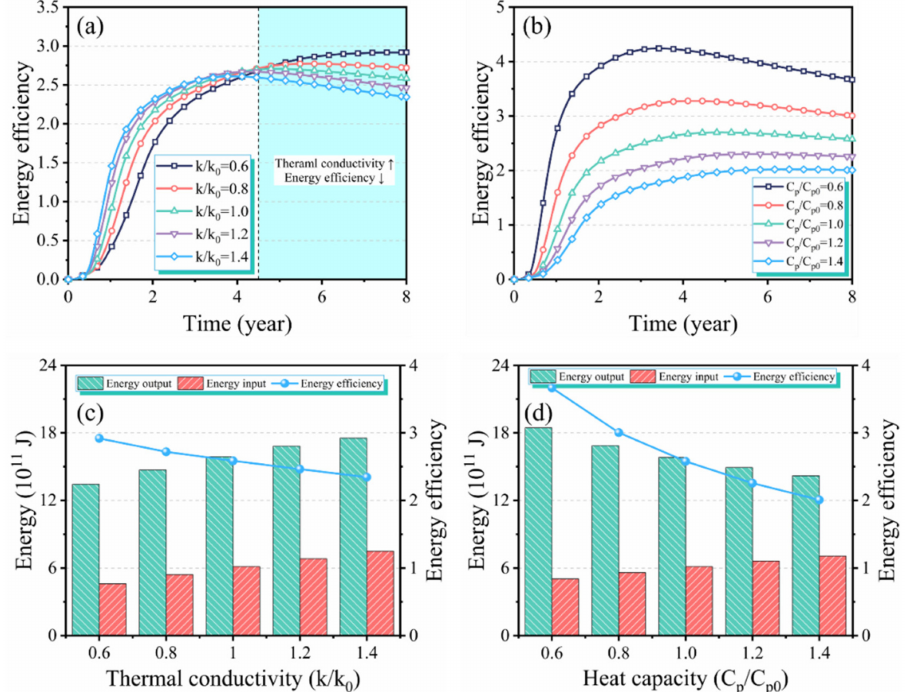
Figure 8. Evolution of energy efficiency under different: ( a ) thermal conductivity; ( b ) heat capac- ity. Cumulative input energy, output energy and energy efficiency under different; ( c ) thermal conductivity; ( d ) heat